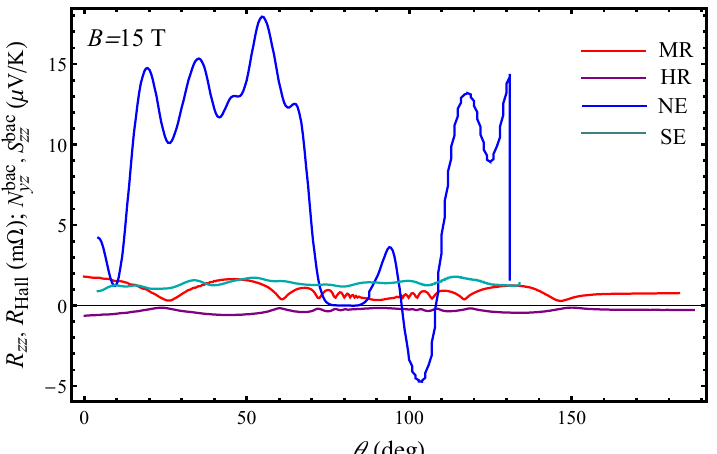
Figure 3. Comparison of the angular dependence of magnetoresistance, Hall resistance, Seebeck and Nernst effect in α - ( BEDT-TTF ) 2 KHg ( SCN ) 4 for B = 15 T and T = 0.6 K. The Nernst effect amplitude is extremely large compared to the amplitude of magnetoresistance, Hall resistance and thermopower in a wide range of angles with exception of the angles near the plane of the